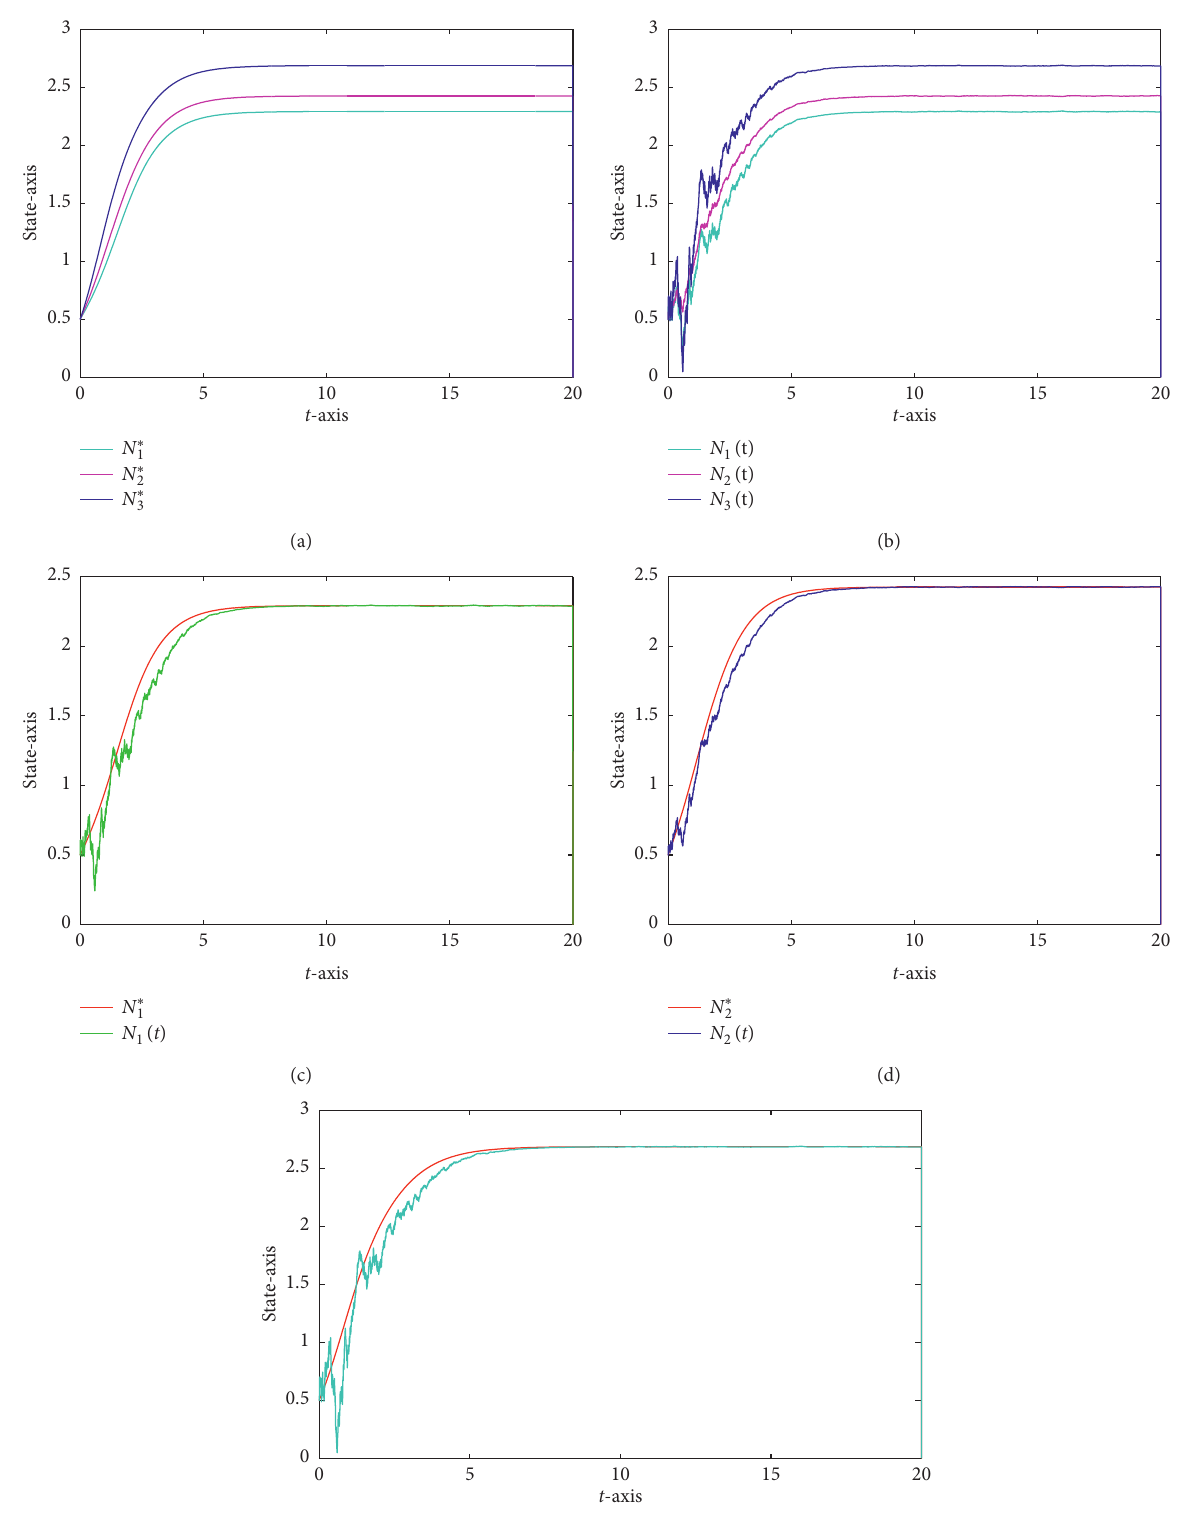
Figure 3: Stable case of system (4) with σ � 2 . 4561 , and N ∗ N ∗ 2 (4) around their corresponding equilibrium points N ∗